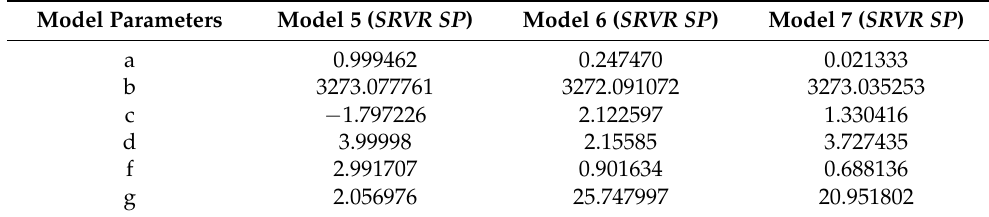
Table 12. Values of the SRVR softening point model parameters of Models